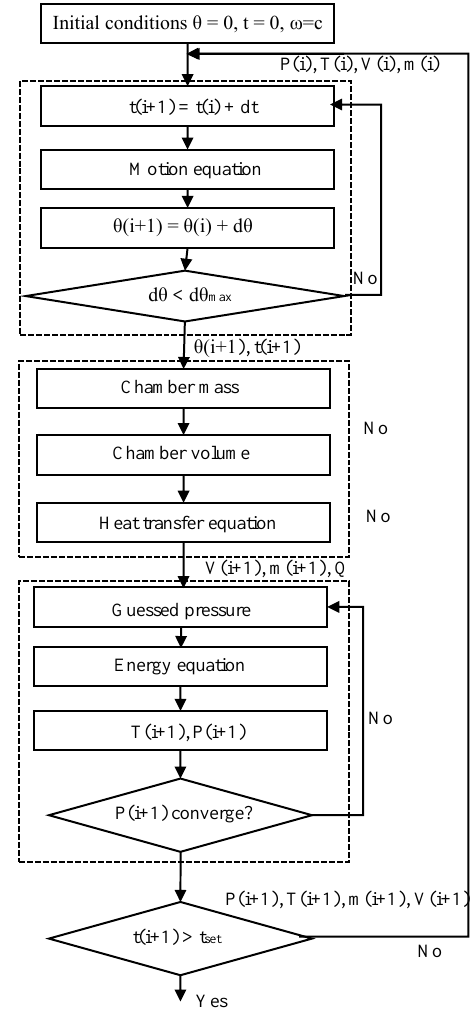
Figure 8. Flowchart for the model